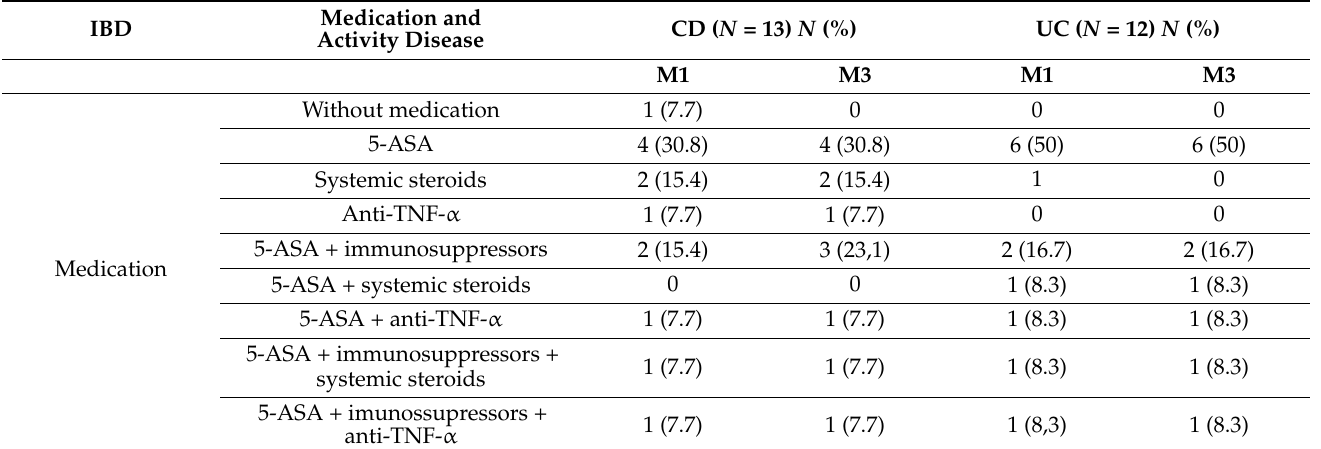
Table 2. Medication and activity disease on individuals with